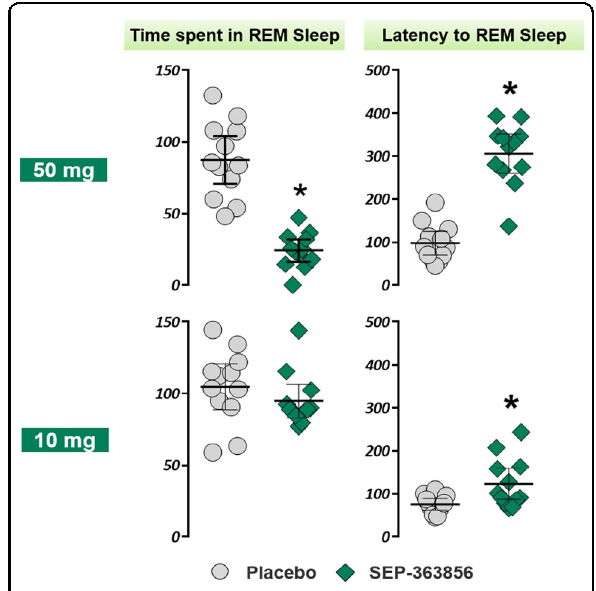
Fig. 2 Time spent in REM sleep (minutes) and latency to REM sleep (minutes) for SEP-363856 vs. placebo. Post-baseline values are shown. N = 24 subjects. Mean ± 95% C.I. * P < 0.05, based on linear mixed model